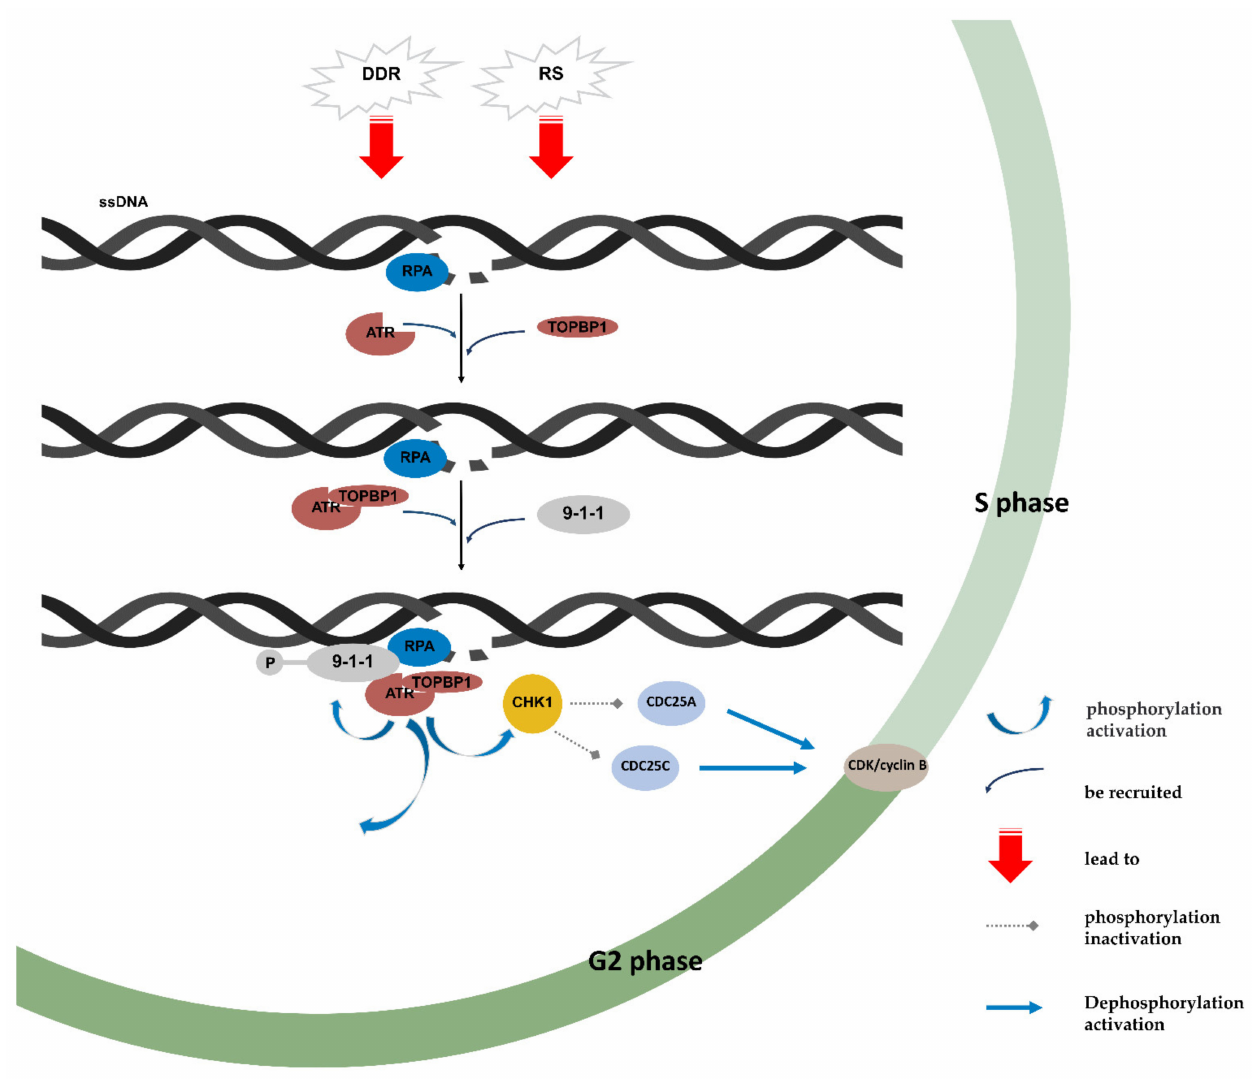
Figure 1. Mechanism of ATR/CHK1-mediated regulation of the cell cycle. Abbreviations: 9-1-1: Rad9- Rad1-Hus1; ATR: ataxia telangiectasia and RAD3-Related Protein Kinase; CDK: cyclin-dependent kinases; CHK1: checkpoint kinase 1; DDR: DNA damage reactions; RPA: replication protein A; RS: replication stress; ssDNA: single-stranded breaks DNA; TOPBP1: topoisomerase-binding protein